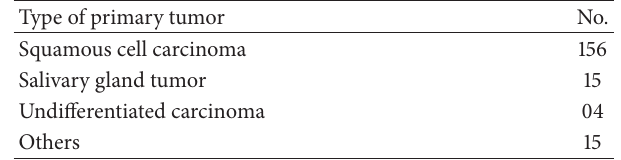
Table 2: Type of primary tumor (𝑛 = 190 patients).